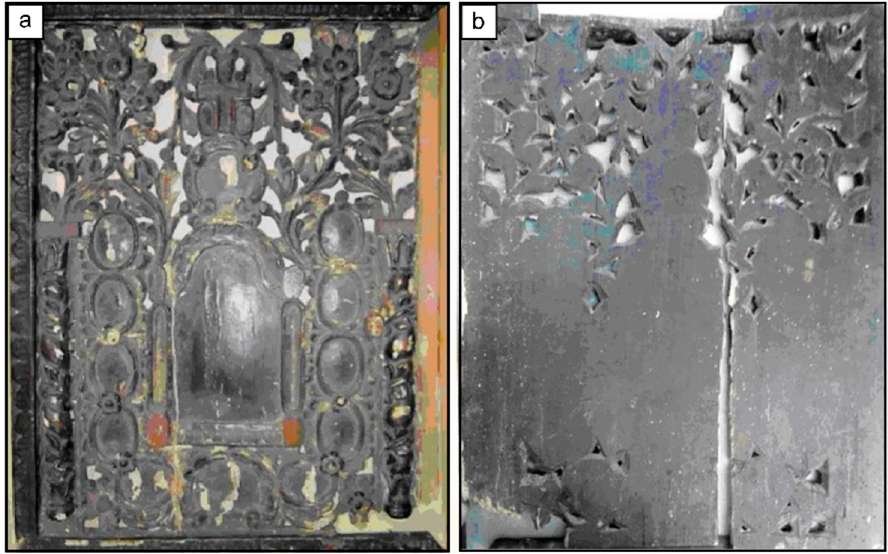
Figure 1. The icon “Coronation of Virgin Mary” in the initial stage of the study: ( a ) Front; ( b )